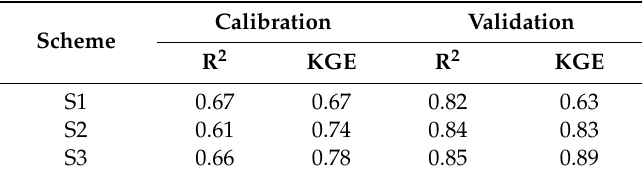
Table 5. Comparison of the average R 2 and KGE for different magnitudes of multiple schemes.